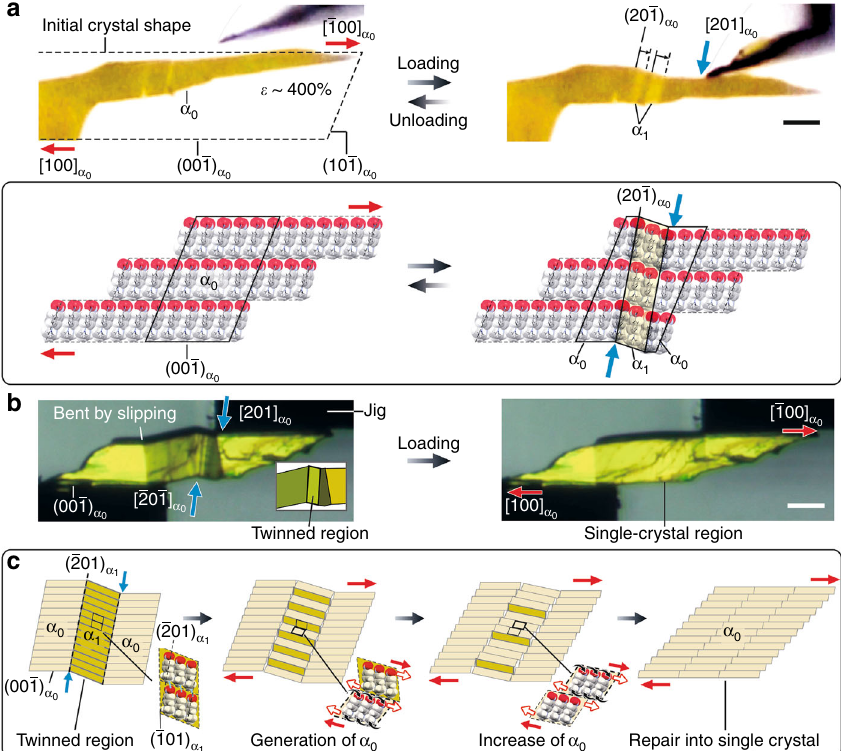
Fig. 4 Coupling of superplasticity and superelasticity. a Superelastic behavior of crystals of 1 after superplastic deformation. The two bright crystal domains ( α 1 ) were observed under a polarizing microscope after shear stress loading. The domains disappeared when the stress was removed. Scale bar, 50 μ m. The schematic model below the crystal photos represents and explains the superelastic deformation in single crystalline regions. b Superplastic behavior during superelastic deformation. Firstly, beam bending by slipping was induced in the crystal of 1 when the jig at the top right of the photo was moved upward. Then the jig was moved downward, twinning a part of the crystal (the bright region in the inset). c Schematic model explaining the recovery of single crystallinity by the generation and increase of α 0 domains in α 1 domains resulting from multi-layer slipping. Scale bar, 200 μ